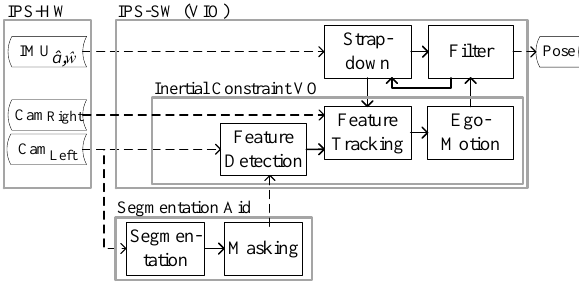
Figure 2. Illustration of the components of IPS and their relations, including sensor system IPS-HW and the navigation module IPS-SW , and the proposed segmentation